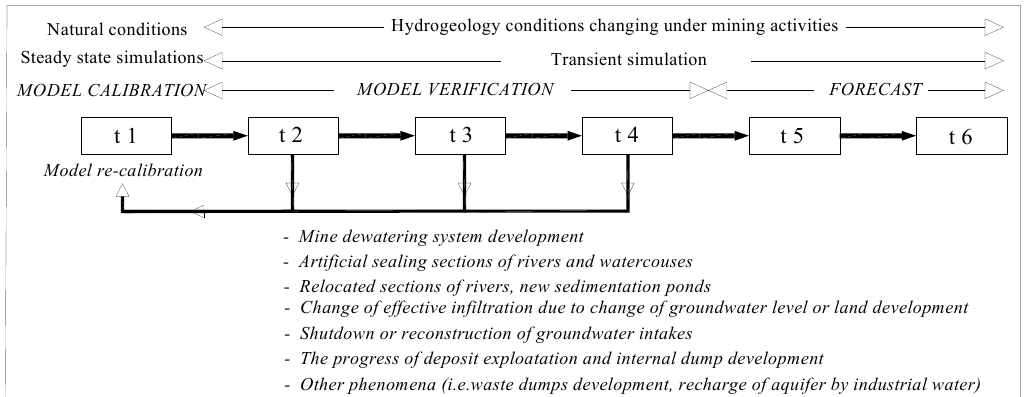
Figure 4. Calibration and verification of numerical models in the opencast mining activity area. Explanation: t1 – t6 : Stress periods; t1 : Natural conditions (before dewatering operation); t2 – t4 : Dewatering period with real monitoring data; t5 – t6 : A forecast of mine dewatering and flooding of the post-mining